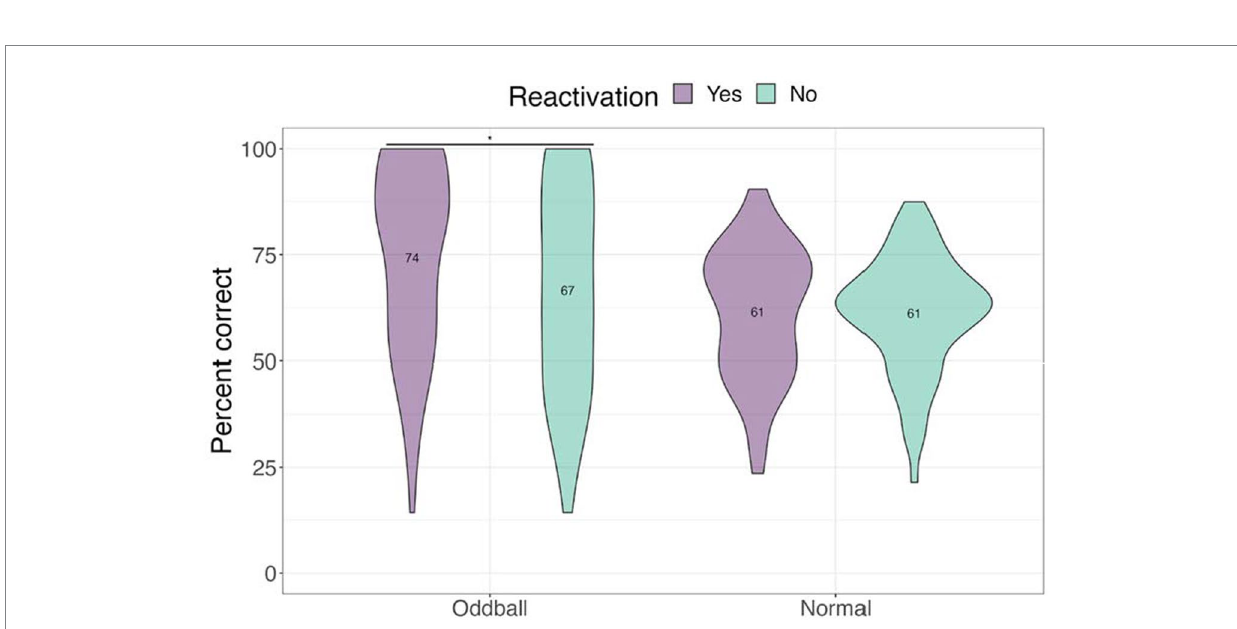
FIGURE 5 Mean accuracy for the location test in Experiment 1. The violin plot is a mirrored density plot with the kernel density estimates on each side (a violin plot combines boxplot and density plots into a single plot). *The significance of p < 0.05.